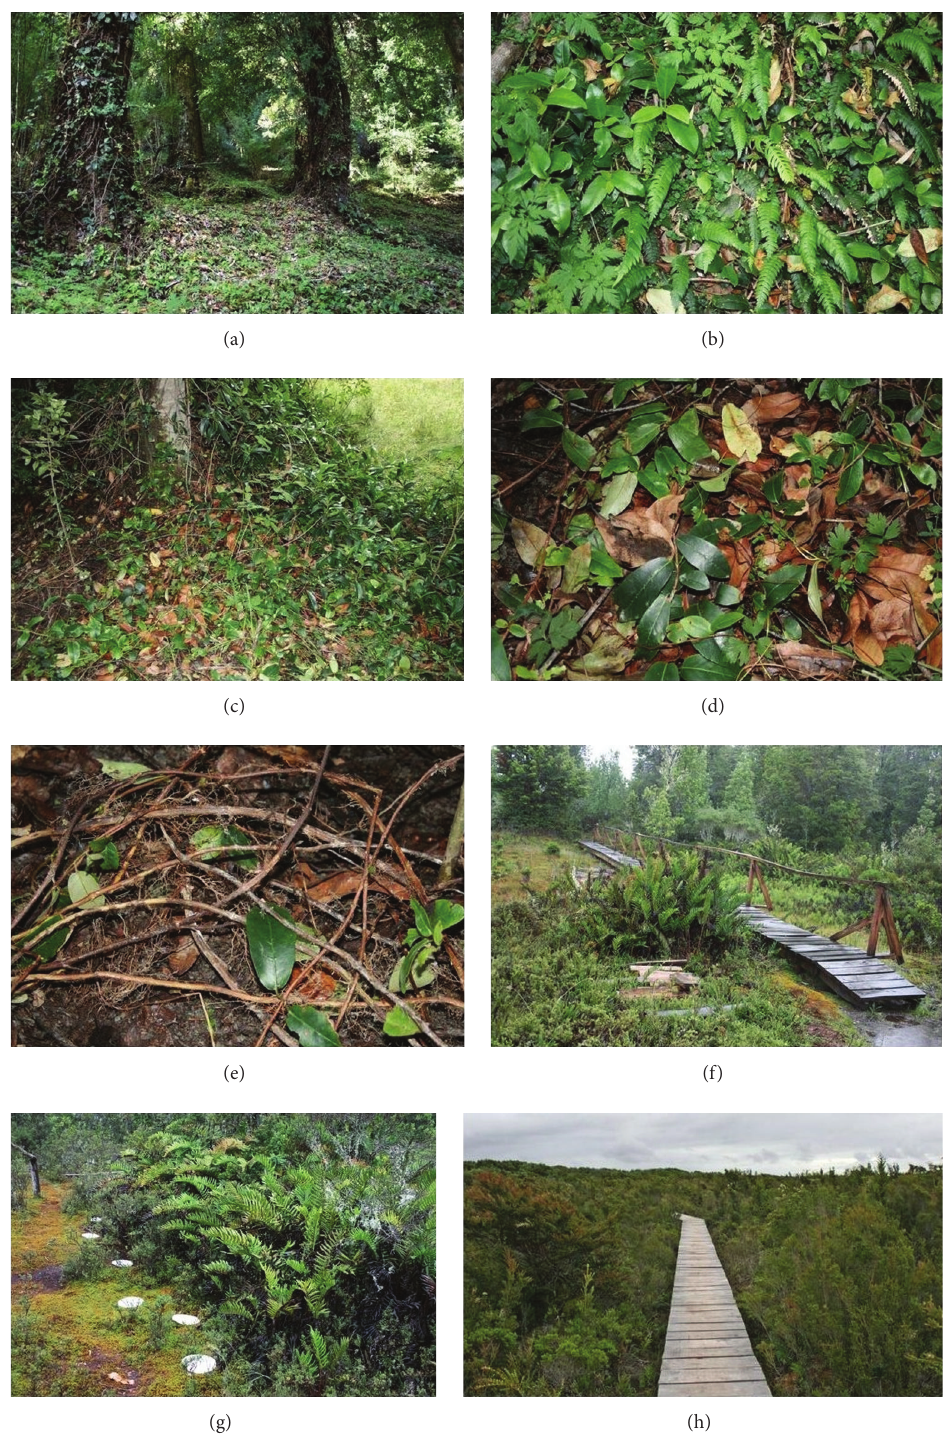
Figure 2: Mapuchea chilensis habitats (collecting sites). (a) Nothofagus forest N of the lake Tinquilco in Huerquehue NP. (b) The same forest floor with ferns and Hydrangea sp. (c) Puyehue NP near Anticura campground, leaf litter near a tree base, with abundant Hydrangea serratifolia . (d) The same, detailed view; note the absence of mosses and ferns. (e) The same, with litter removed to expose creeping stems of H. serratifolia ; also note the abundant volcanic ash deposited upon the 2011 Puyehue-Cord´on Caulle eruption. (f) Shrub bog at the biological station Senda Darwin on Chilo ´ e. (g) The same, showing pan traps. (h) Shrub bog in Chiloe NP near